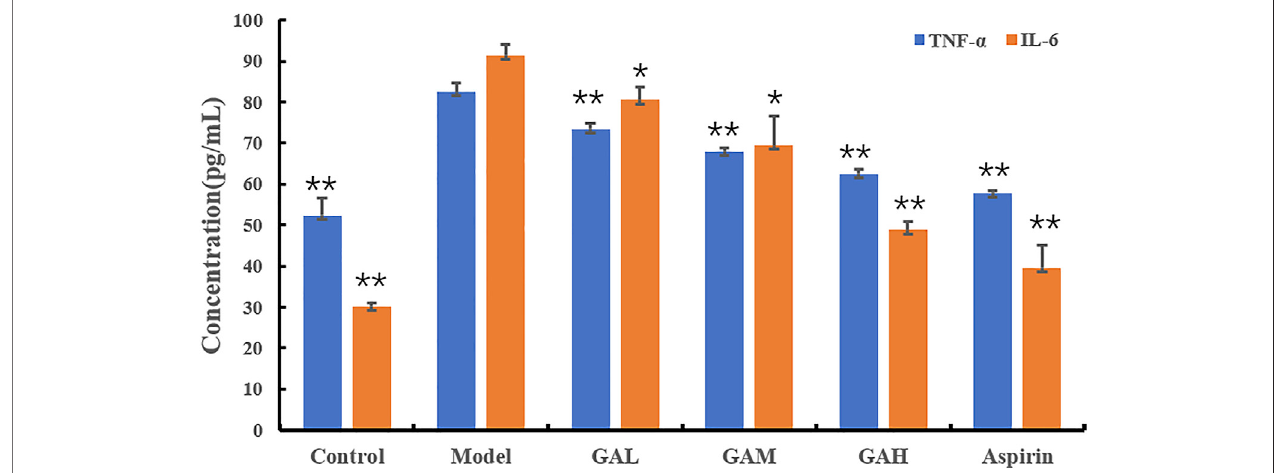
FIGURE 1 | Effects of different doses of gallic acid on the levels of TNF- α and IL-6 (mean ± SD). Note: Signi fi cant differences were based on a two-tailed t -test. Compared with the Model group, * p < 0.05, ** p < 0.01.